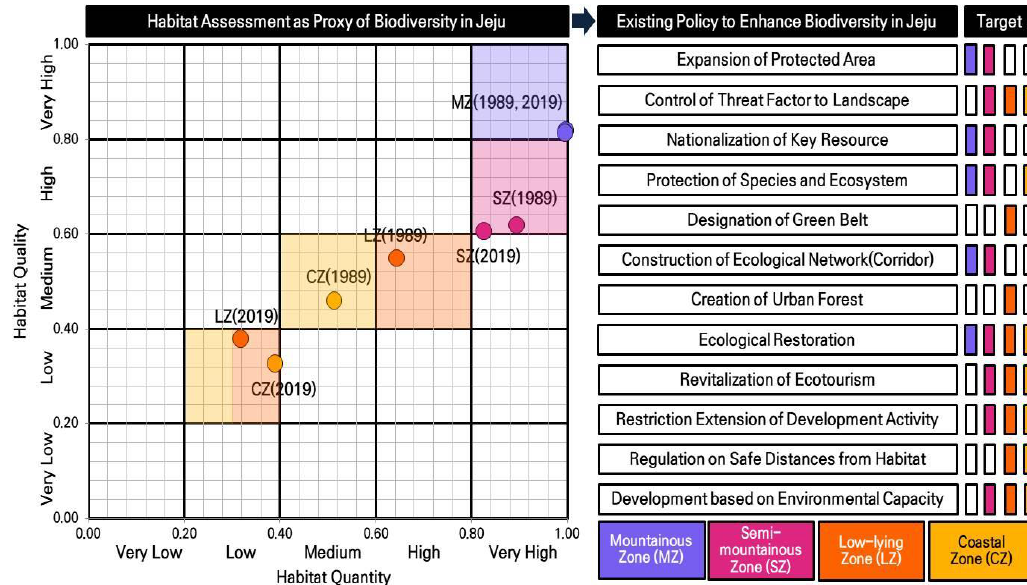
Figure 4. Connection between existing policy alternatives and application target zones based on habitat quality assessment and monitoring for the improvement of biodiversity in Jeju, South Korea.